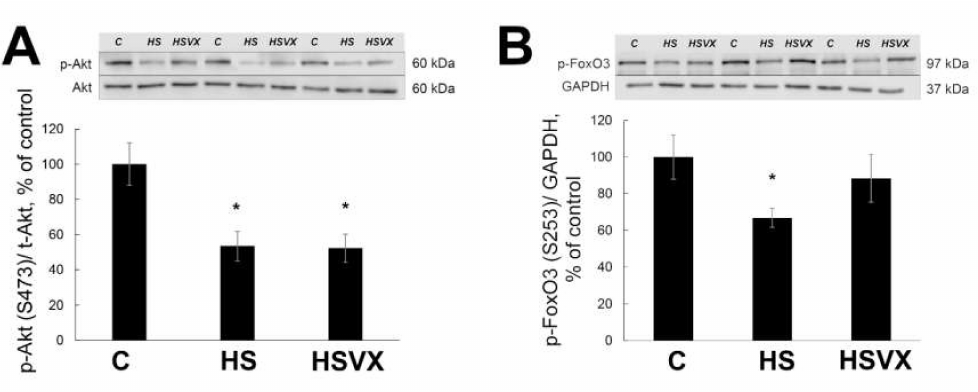
Figure 5. Evaluation of phospho-Akt ( A ) and phospho-FoxO3 ( B ) content in soleus muscles of C, HS, and HSVX rats by Western blotting. Values are normalized to the levels of total protein and total Akt or GAPDH content in each sample. n = 8. * indicates a significant di ff erence from the control, p < 0.05; # indicates a significant di ff erence from the HS, p < 0.05.